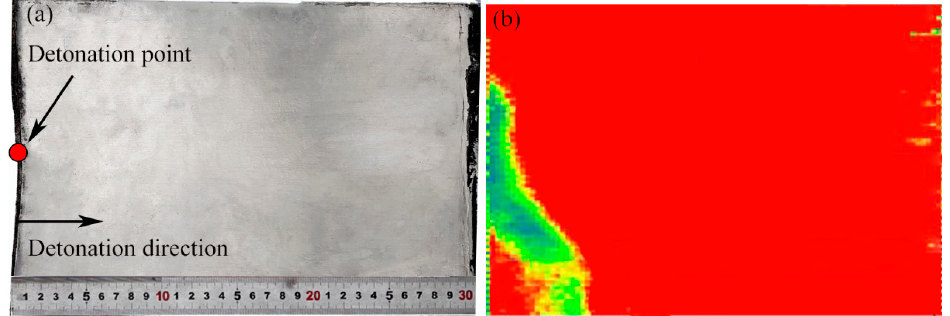
Figure 5. Macroscopic feature of AA5052/AZ31B plate, ( a ) photograph of AZ31B surface, ( b ) ultrasonic testing results.